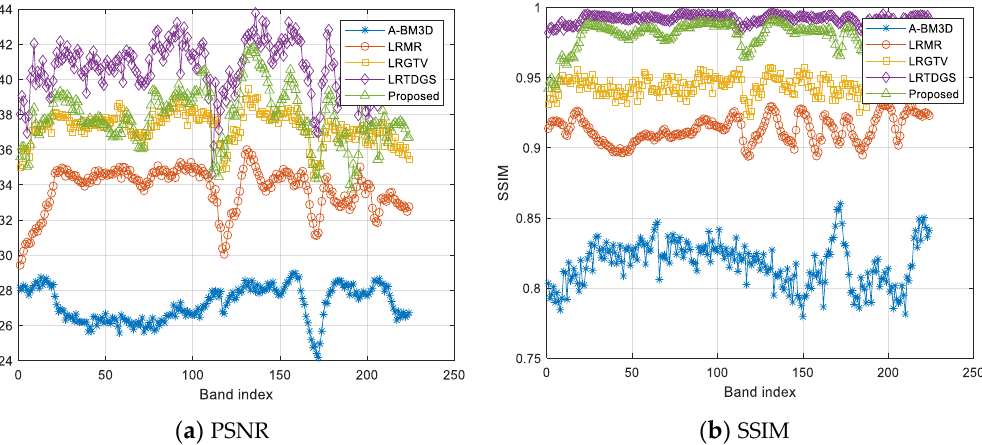
Figure 6. PSNR and SSIM values of restored results by different methods on Simu – Indian data (G = 0.10, S = 0.20).